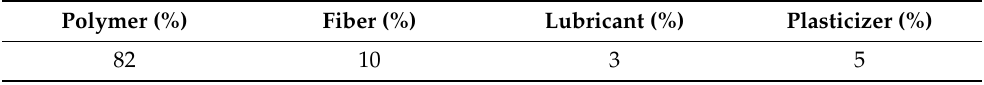
Table 2. Simulation material